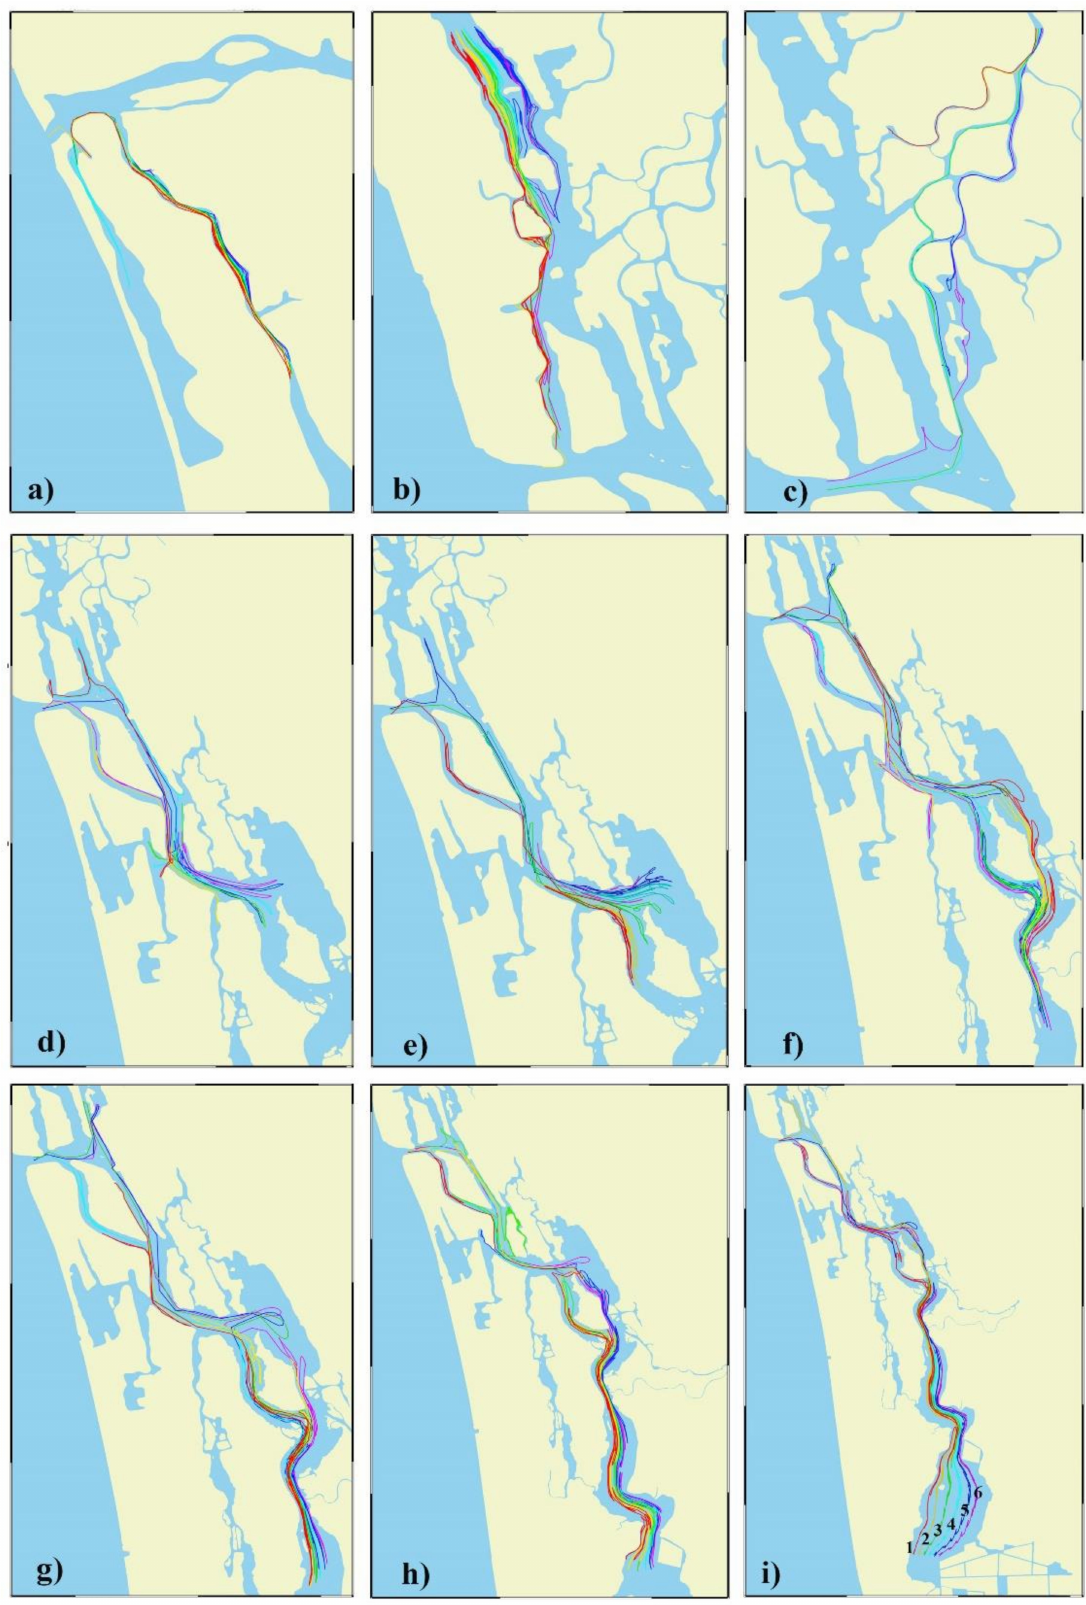
Figure 21. Trajectories of the particles released at nine locations as mentioned in the Table 5 ( a – i ) during the monsoon period is shown as Red (1), yellow (2), green (3), cyan (4), blue (5) and magenta (6) according to its lateral